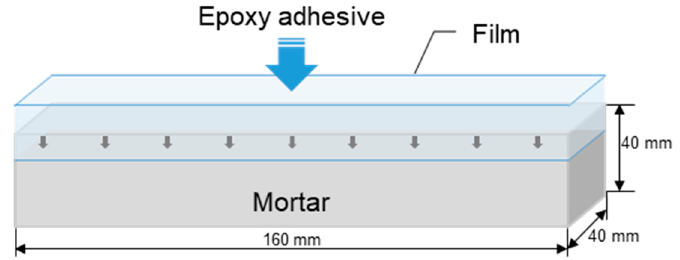
Figure 3. Test method for permeability of the epoxy resin adhesive.